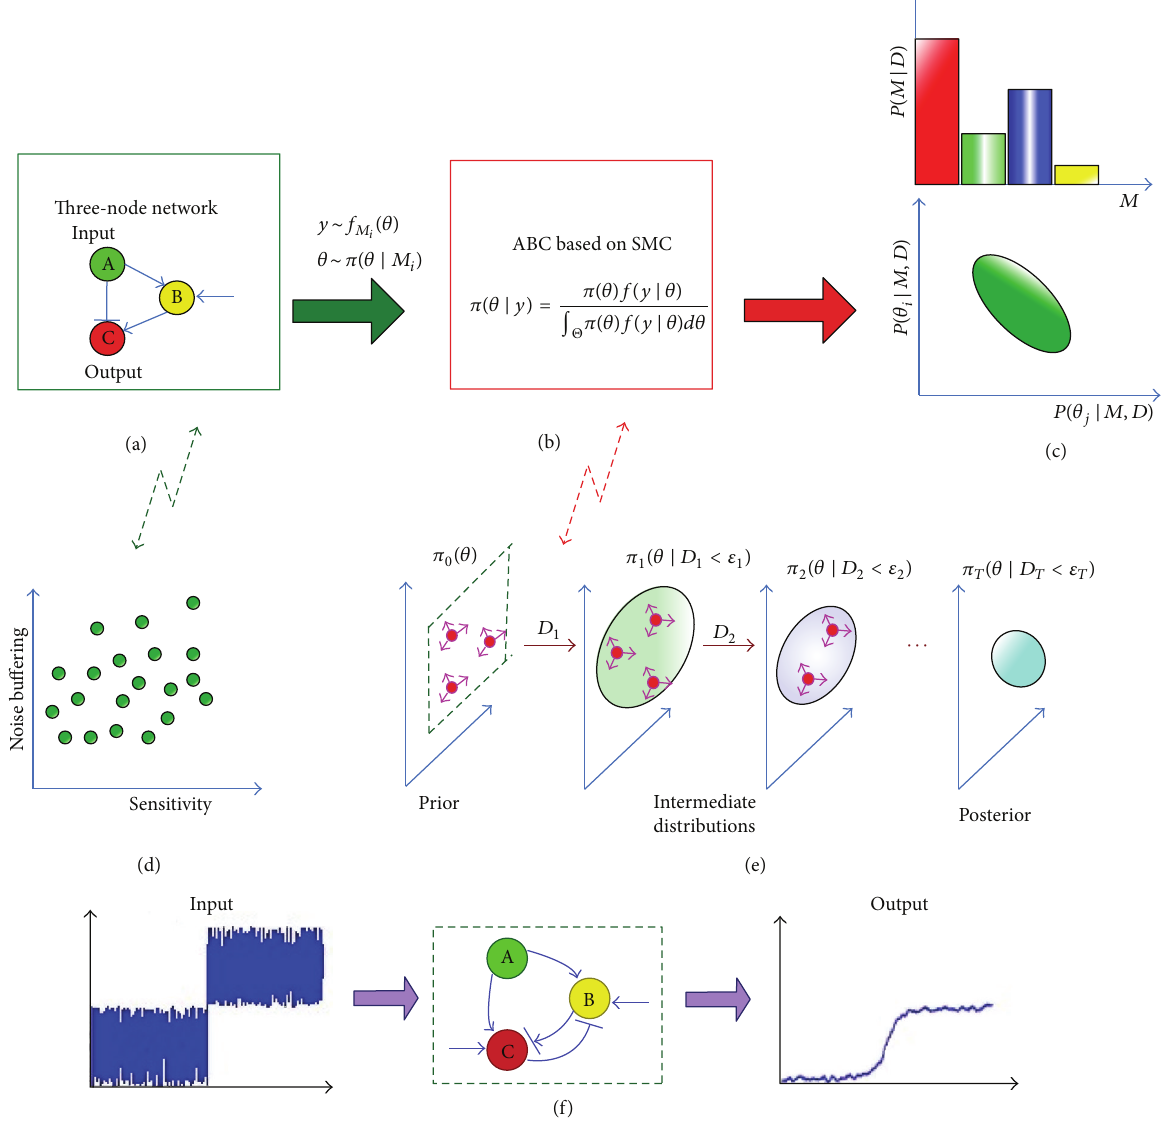
Figure 1: The framework of the proposed method. (a) A three-node candidate network with “ ⊣ ” indicating negative regulation and “ → ” indicating positive regulation. (b) The employed model selection tool. (c) The model posterior probability indicates the ability of each network structure to buffer noise without losing sensitivity. The parameter posterior shows parameters that are sensitive or insensitive to the input- output specification. (d) The noise buffering and sensitivity are employed to specify the input-output character of the three-node biological network. (e) The model parameter is evolved using sequential Monte Carlo. (f) A typical profile of an input signal and a profile of the output signal after going through a three-node network that can maintain signaling sensitivity while minimizing noise